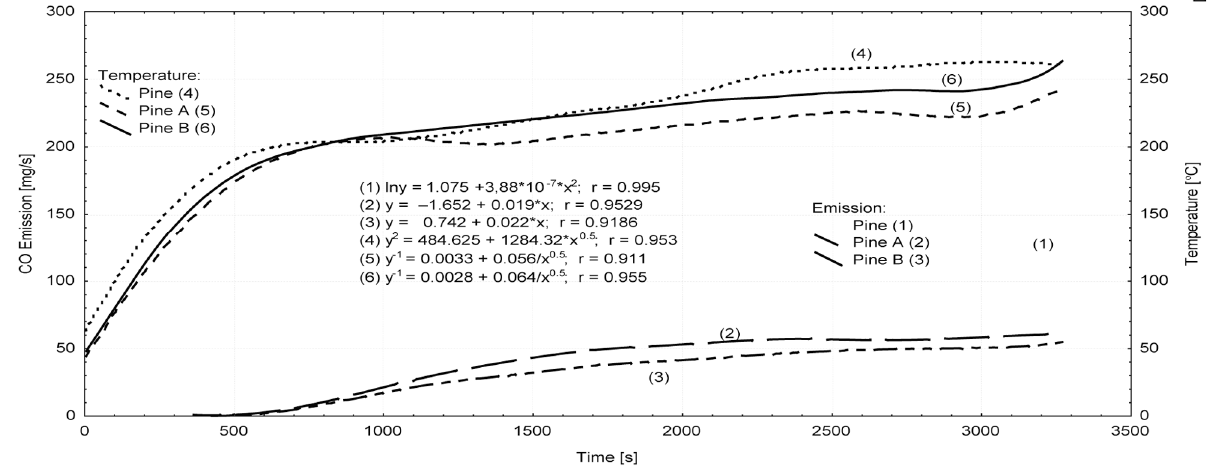
Fig. 5. Average emissions of CO from tested specimens and alternation of average temperature on the surface of tested specimens 2 affected by heat sources of 8 kW/m subjected to time: (1) – non-treated pine timber specimens; (2) – pine timber specimens treated with A; (3) – pine timber specimens treated with B; (4) – non-treated pine timber specimens; (5) – pine timber specimens treated with A; (6) – pine timber specimens treated with